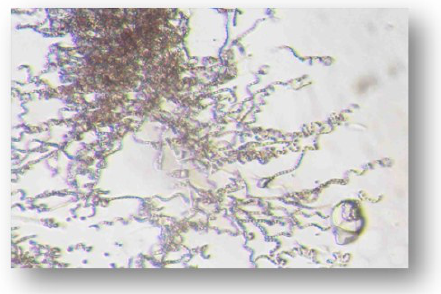
Figure 1b. Transmission electron Figure 1a. Light microscope of aerial micrograph (spores spiny) for strain NRC- mycelium (Spiral) for strain NRC-15 (800X) 15 at 20.000X for 21 days at 28 º C using for 14 days at 28 ºC using Bennett’s medium. Bennett’s medium. Table 1. Cultural characteristics of Str. pseudogrisiolus NRC-15 at 7-14 days. Color of Soluble Medium No. Growth Pigment AM SM ISP2 abundant Gray pale yellow brown ISP3 fair Gray beige no ISP4 abundant Gray beige no ISP5 abundant Gray brown no ISP7 abundant Gray brownish no Bennett’s abundant Gray pale yellow brown Czapeks moderate Gray Light brown Light brown Nutrient agar moderate White yellowish no Glucose asparagine moderate white beige